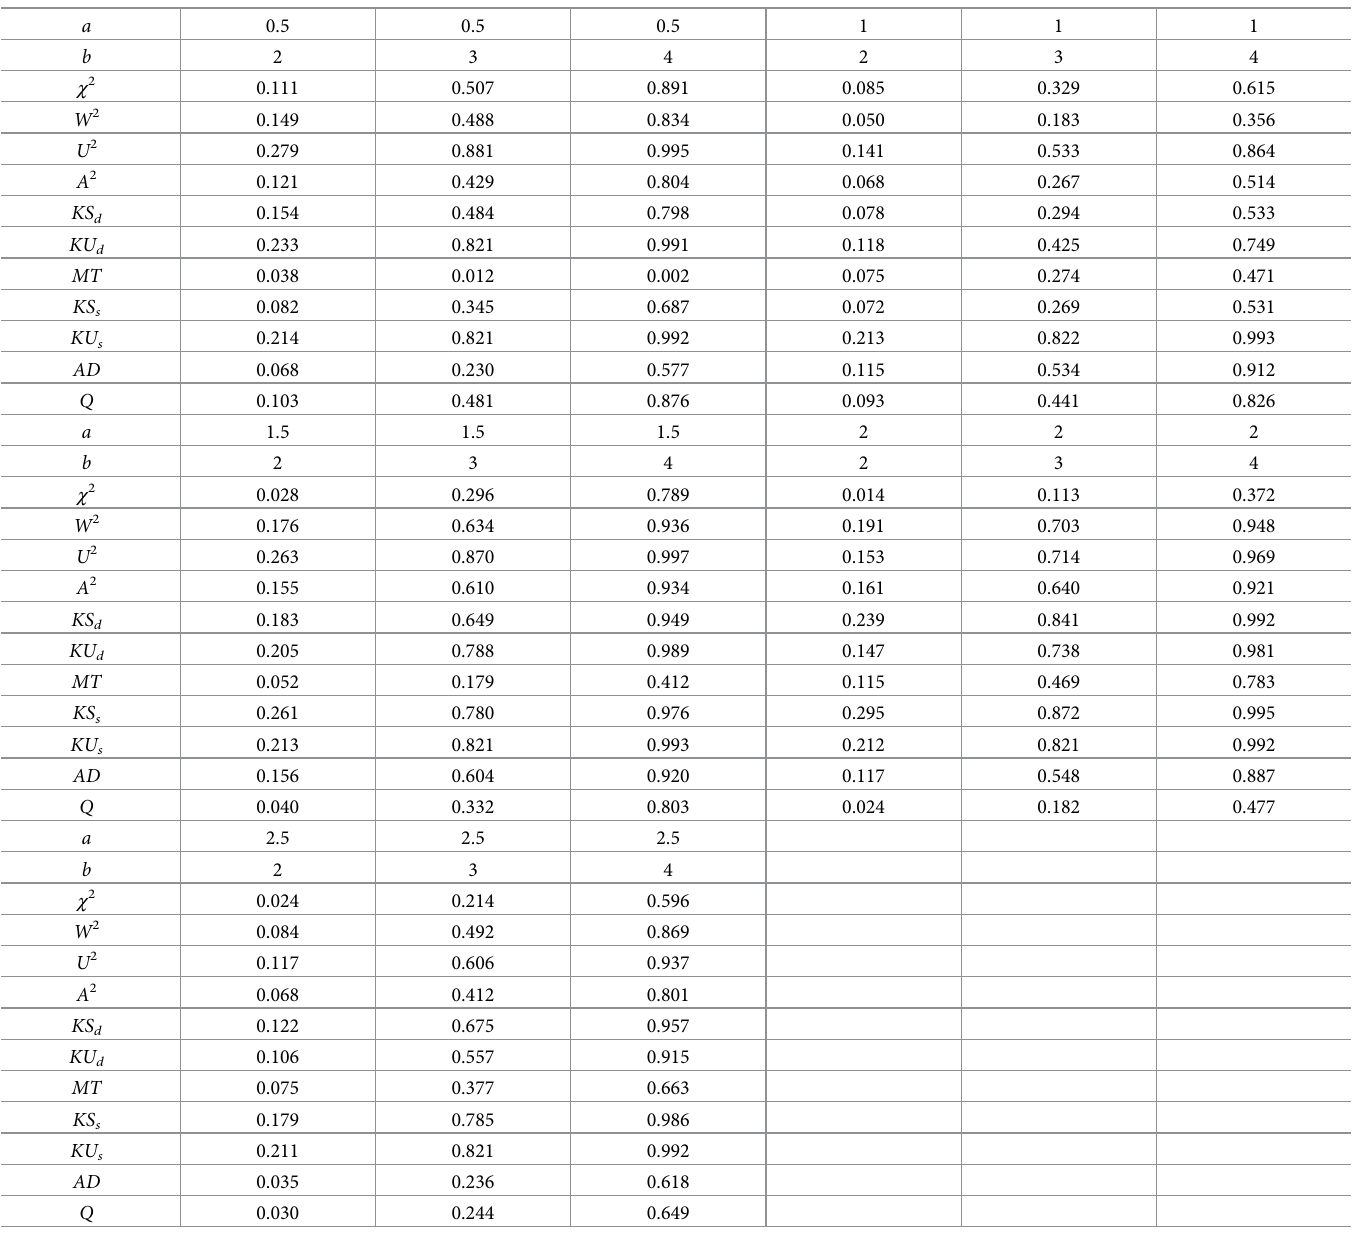
Table 5. Rejection rates for Weibull distributed